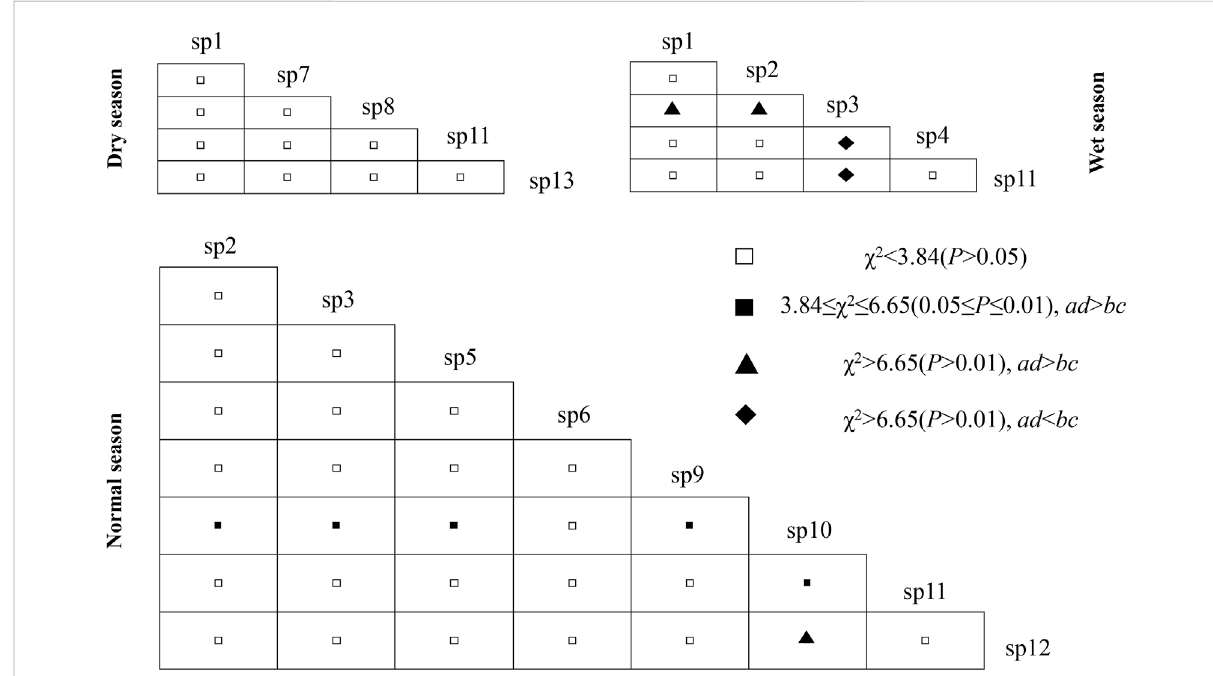
FIGURE 5 Half matrix of association coef fi cients χ 2 test among the dominant phytoplankton species in different hydrological seasons. The dominant species number and their corresponding relationships in the fi gure were consistent with those in Table 2.